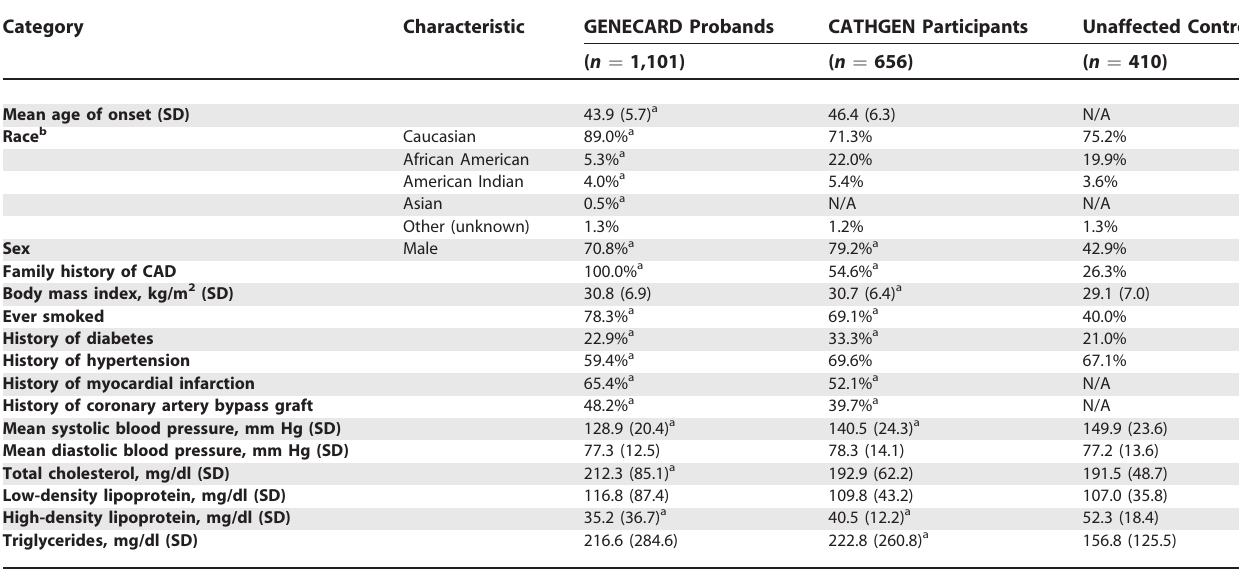
Table 3. Clinical Characteristics of GENECARD Probands and CATHGEN Participants Category